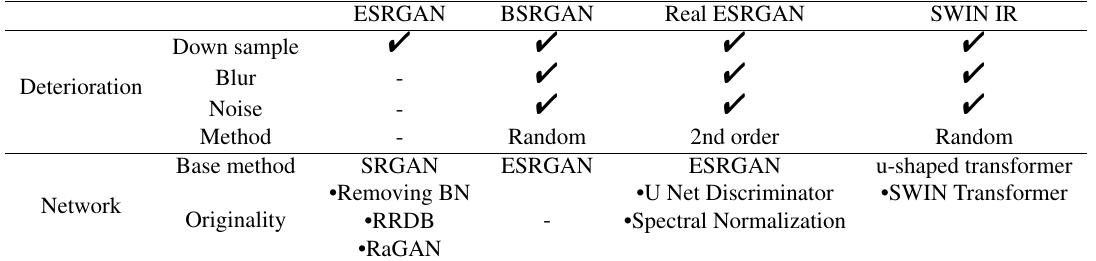
Table 1. Pre-trained super-resolution models are used in this paper.